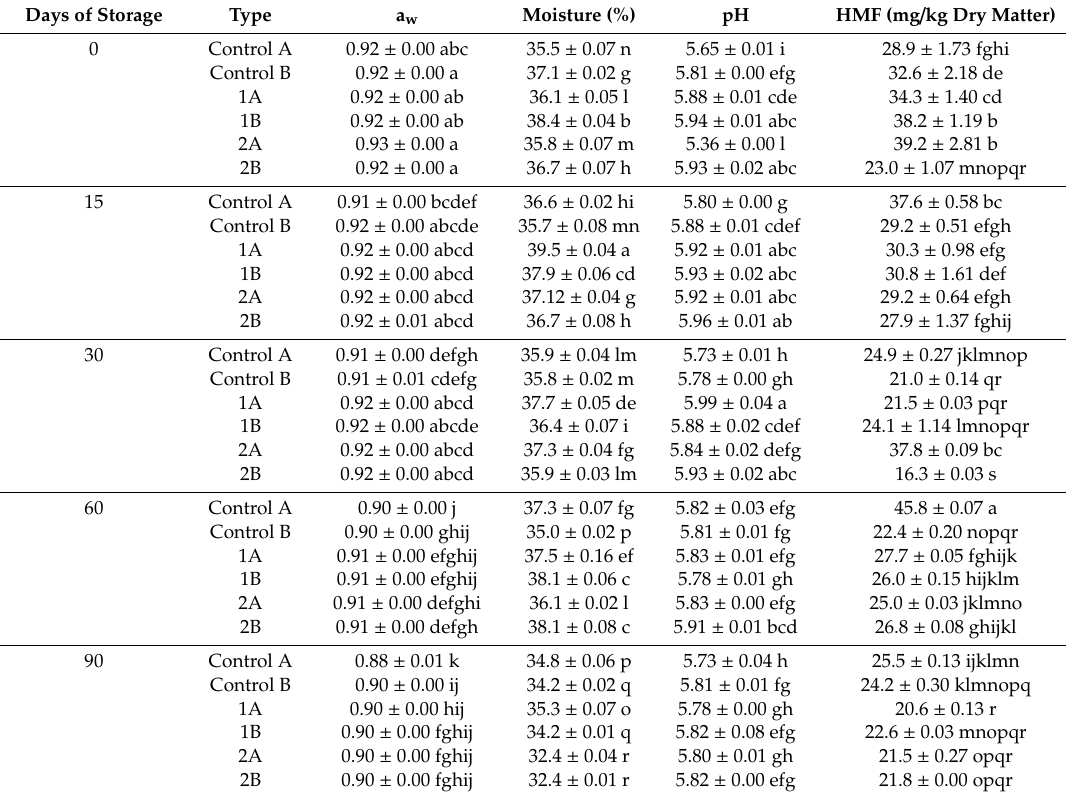
Table 8. Evaluation of the chemical characteristics of the bread samples produced using di ff erent types and levels of sea salt during storage (data are means ± standard